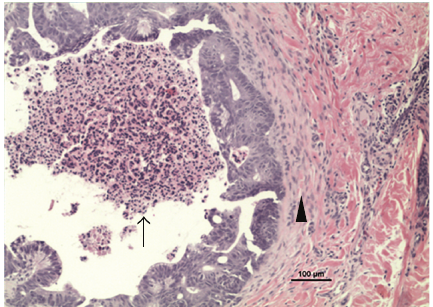
Figure 1: Multiple, erythematous, lesions of varying size present on the skin of the left lower extremity.